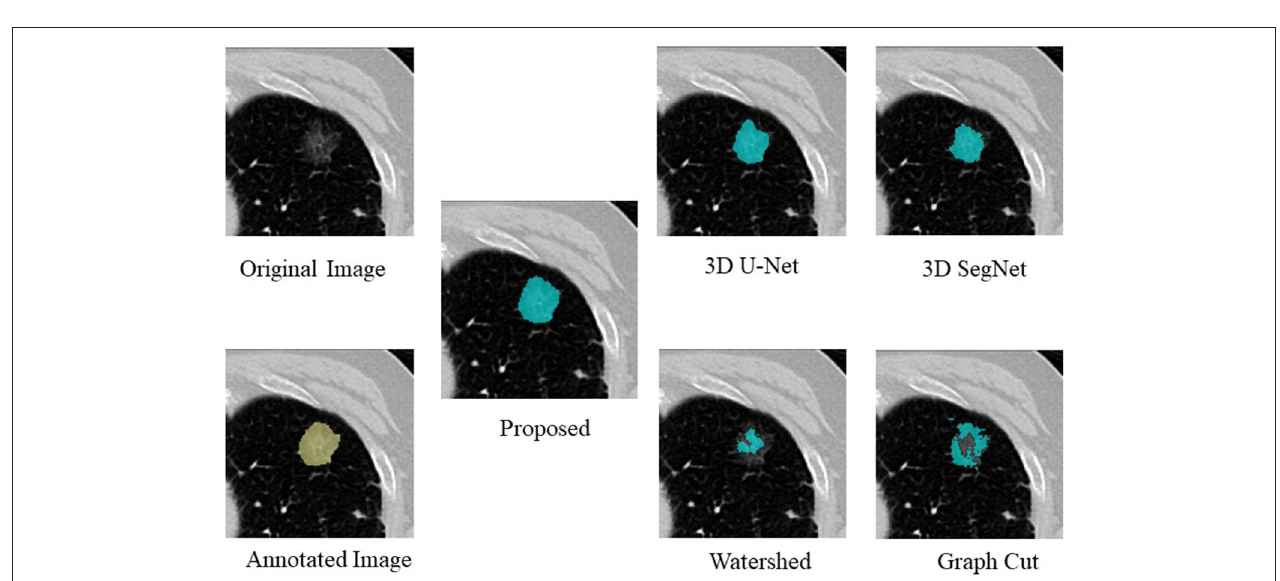
FIGURE 3 | Examples of segmentation results in the case of a GGO nodule.